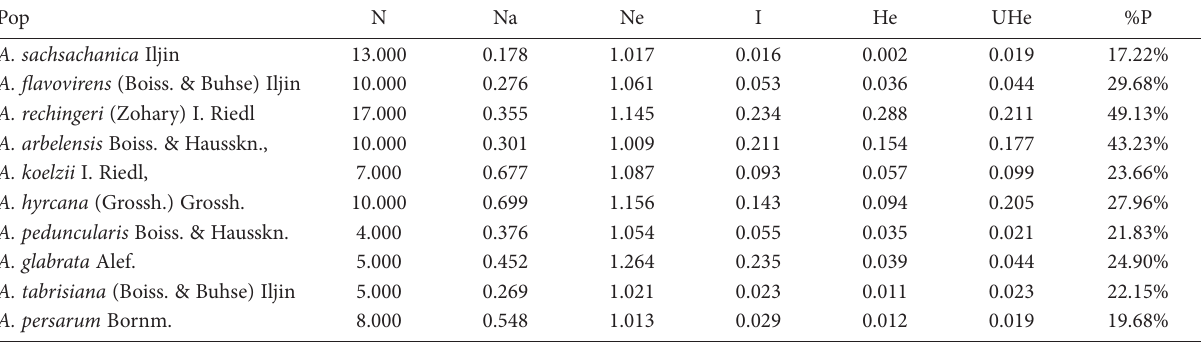
Table 3. Genetic diversity parameters in the studied Alcea species. (N = number of samples, Ne = number of effective alleles, I= Shannon’s